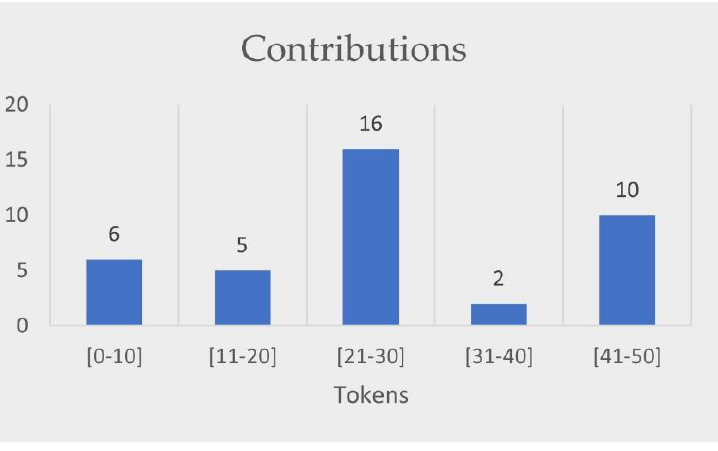
Figure 14. Distribution of sent amounts in the trust game.